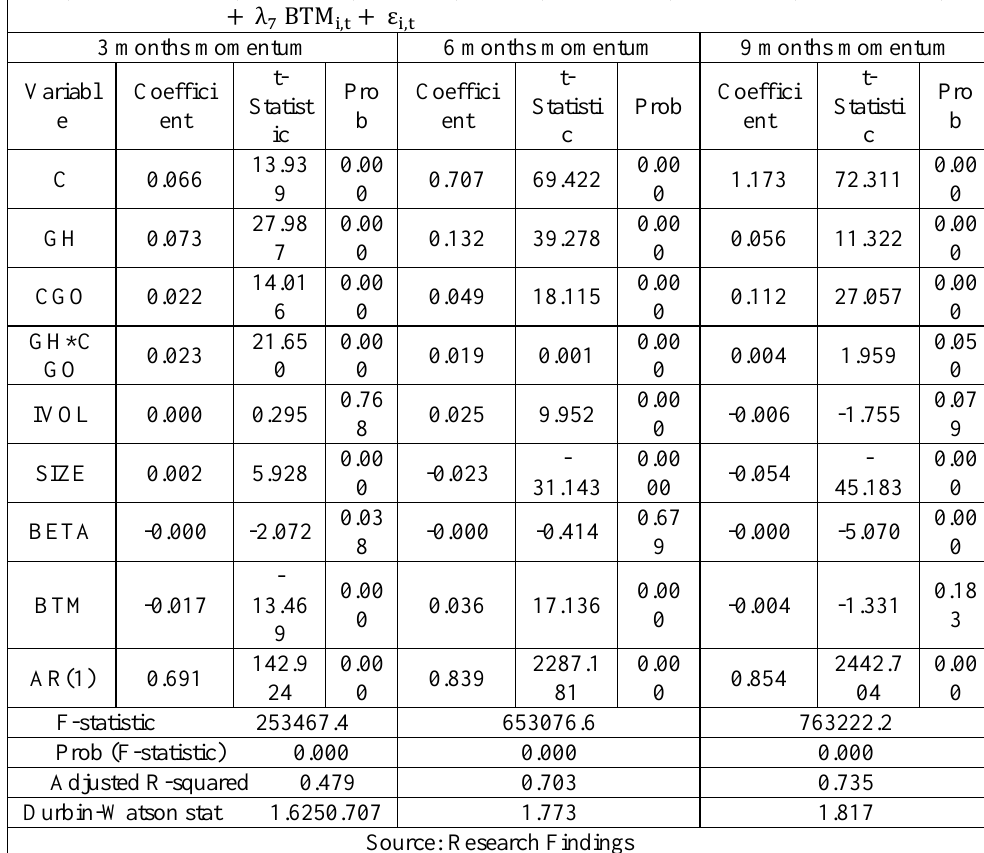
Table 4. Regression results for the effect of the anchoring bias and the